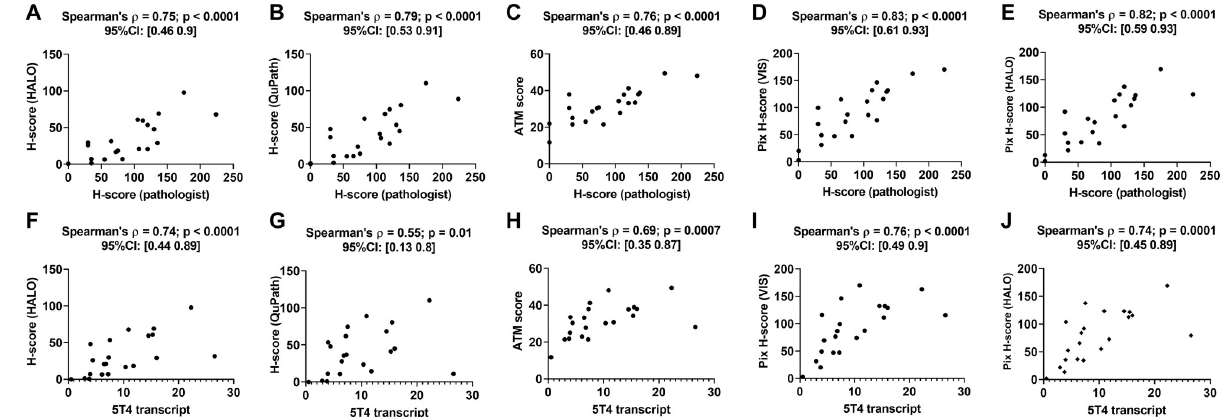
Fig 5. Performance of DIA endpoints obtained from 5T4 IHC images. Panels A-E show plots of the different DIA endpoints as a function of the pathologist H-score, while panels F-J show the same as a function of 5T4 mRNA transcript for a cohort of 21 lung cancer resections. All panels show the Spearman’s correlation coefficient between the two quantities plotted in that panel along with the p-value and the 95% confidence interval. https://doi.org/10.1371/journal.pone.0245638.g005 pix H-score with respect to 5T4 transcript were 0.74 (p < 0.0001), 0.55 (p = 0.01), 0.69 (p = 0.0007), 0.76 (p < 0.0001) and 0.74 (p = 0.0001), respectively. Statistical analysis of the Spearman’s correlation coefficients revealed that there is no signifi- cant difference in the correlation coefficient between each of the DIA based endpoints and pathologist H-score (Table 3). An analogous behavior was also observed for the correlation coefficient between each of the DIA based endpoints and 5T4 transcript except for the QuPath H-score. Specifically, the correlation between QuPath H-score and 5T4 transcript was Table 3. Table lists the results of William’s t-test to test for significant difference in the Spearman correlation coefficients between 5T4 mRNA transcript or pathol- ogist H-score and different DIA endpoints. Statistical analysis of correlation coefficients for 5T4 ρ